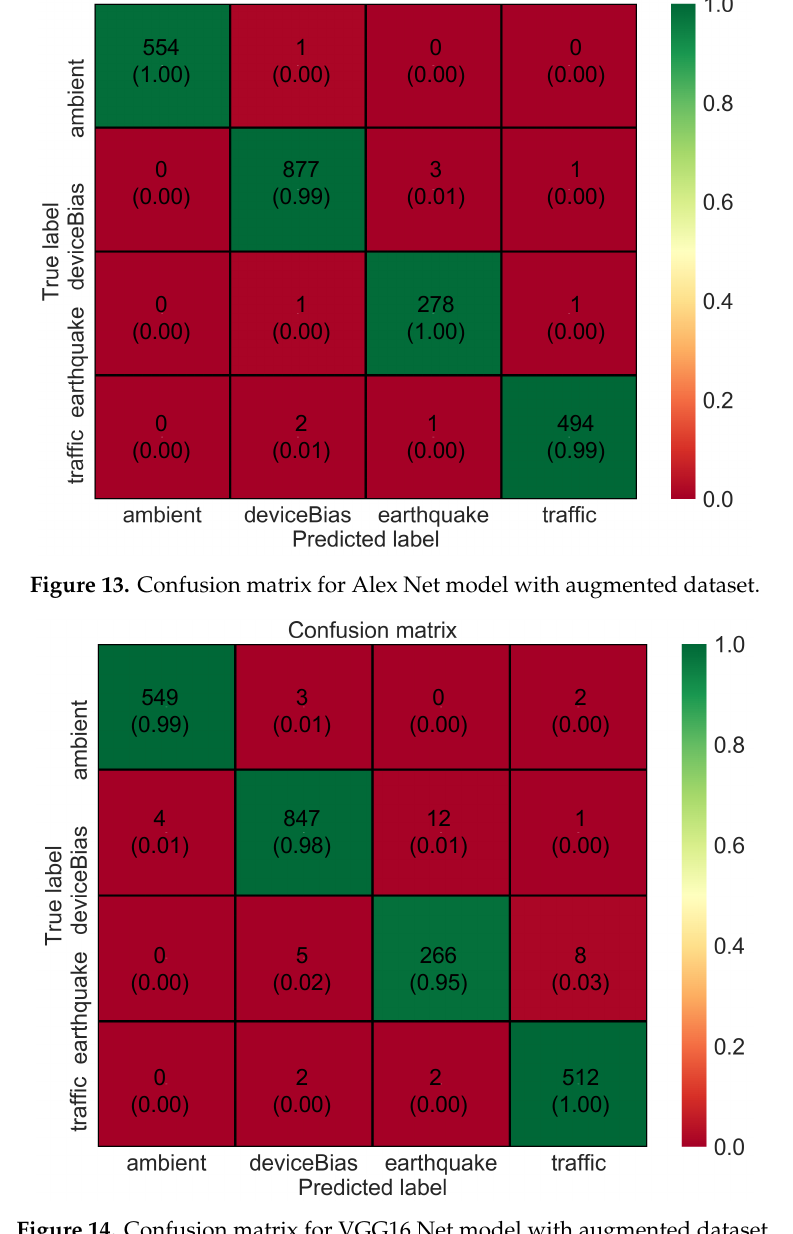
Figure 14. Confusion matrix for VGG16 Net model with augmented